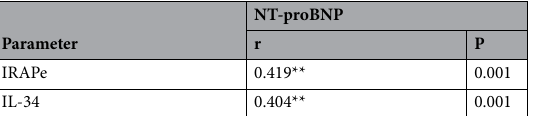
Table 3. Pearson correlation between NT-proBNP with IRAPe, and IL-34. IRAPe extracellular domain of insulin regulated aminopeptidase, IL-34 interleukin-34, NT-proBNP N-terminal pro b-type natriuretic peptide. **Correlation is significant at the 0.01 level